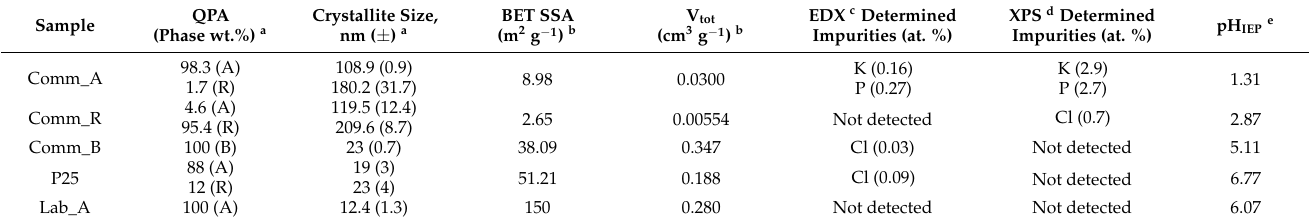
Figure 1. XRD patterns of the studied powder samples. The main peaks of anatase, rutile, and brookite are labeled as A, R, and B, respectively. Table 1. Some relevant textural and surface properties of the studied powder samples as obtained by elemental analysis, and e electrophoretic